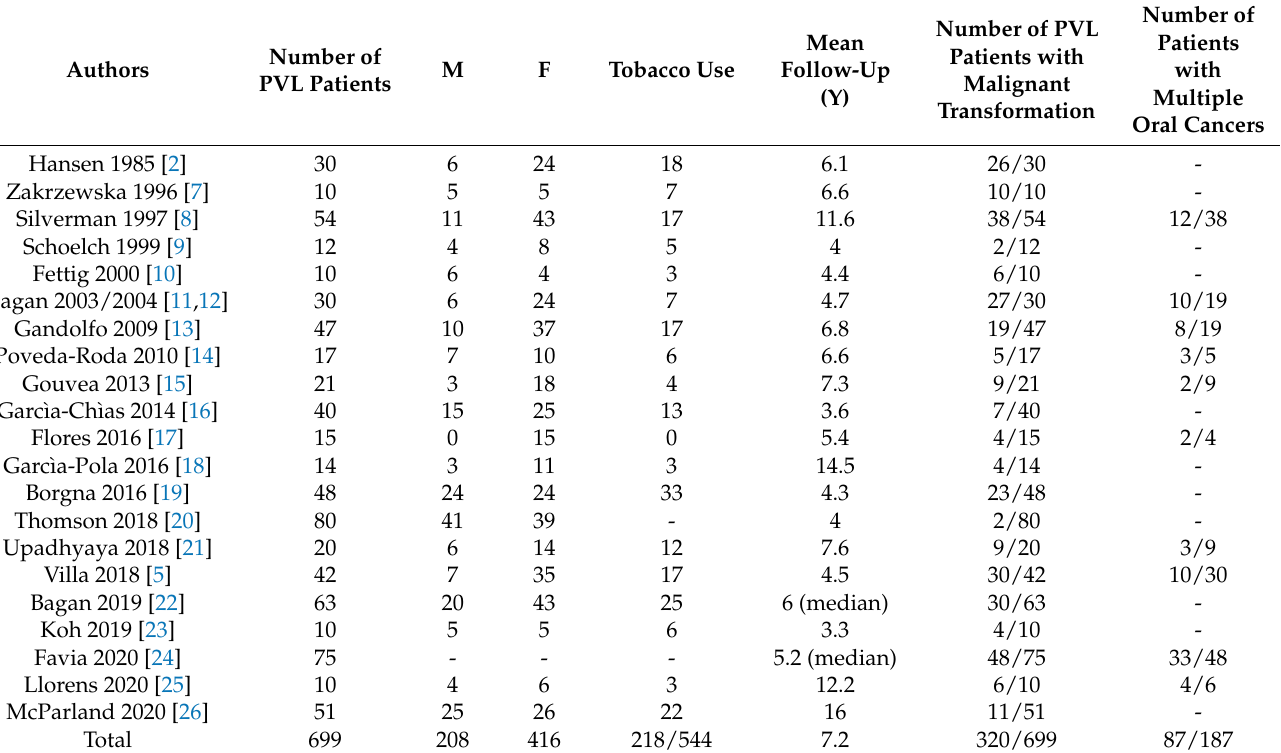
Table 3. Data relating to the number of PVL patients, sex, tobacco consumption, mean follow-up, number of patients with neoplastic evolution of PVL and with development of multiple oral carcinomas.